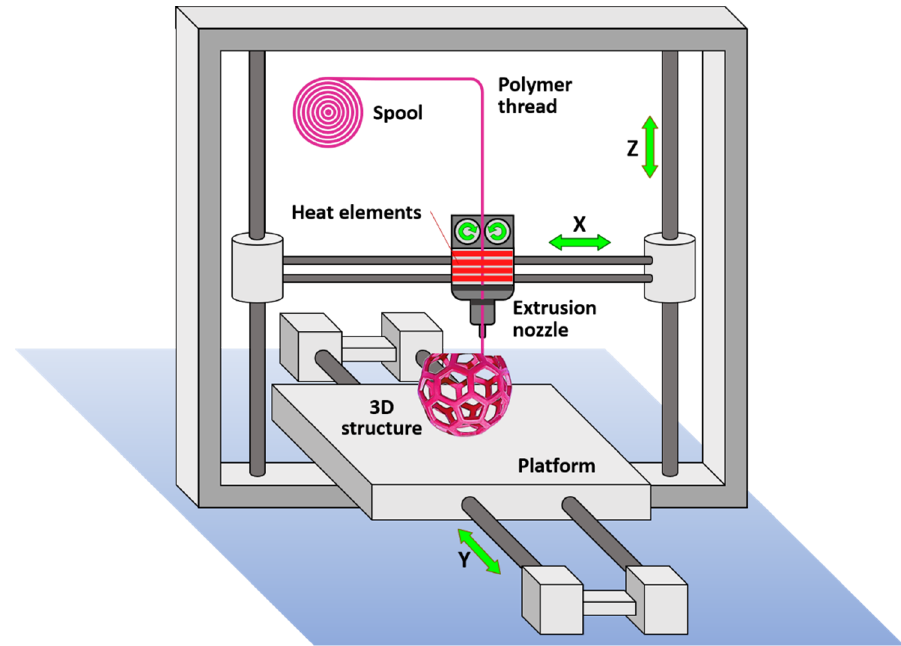
Figure 5. Schematic illustration of 3D printing by the modeled fused deposition technology.